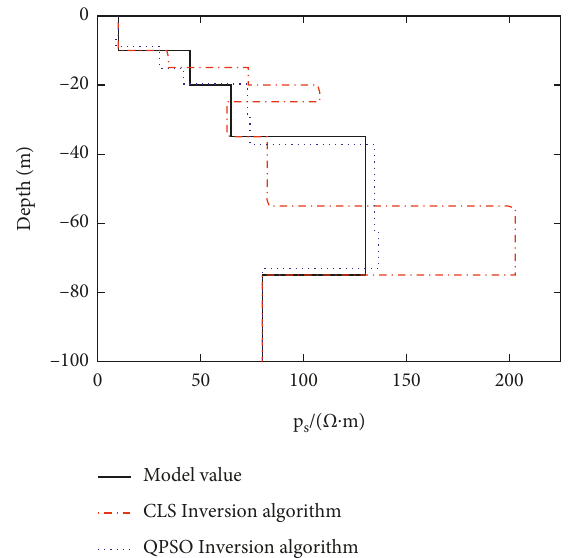
Figure 5: Inversion results of the QPSO algorithm and the CLS